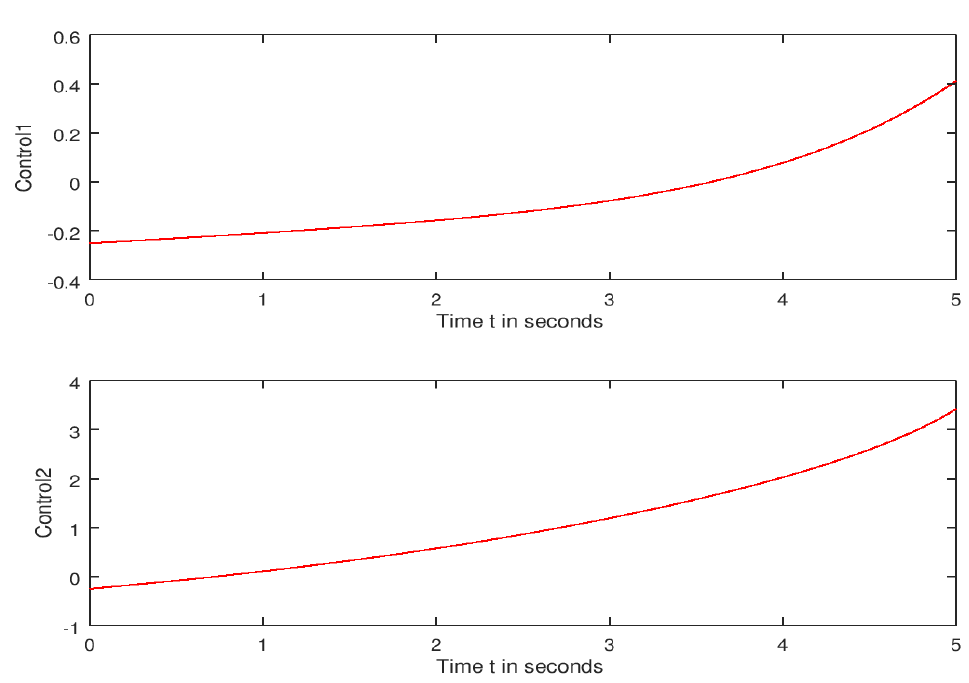
Figure 8. Feasible Control functions.